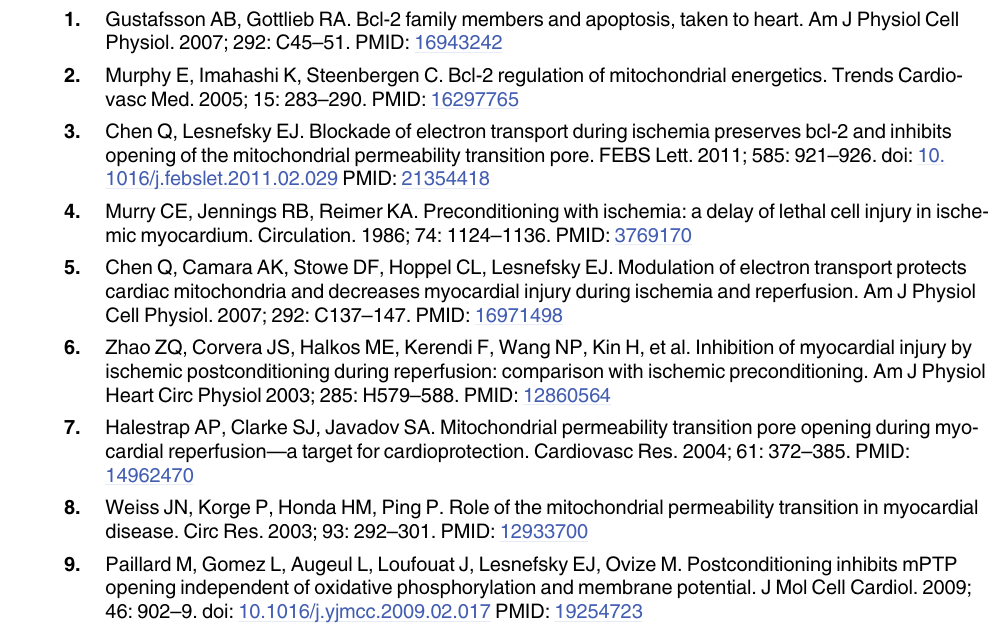
S3 Fig. Ischemia-reperfusion decreased cytosolic bcl-2 content. Buffer perfused rat hearts were subjected to 25 min global ischemia and 30 min reperfusion. Bcl-2 content in cytosol was determined using western blotting. The bcl-2 content is decreased in hearts following ische- mia-reperfusion compared to time control. Tubulin was used as a protein loading control. S4 Fig. Ischemia-reperfusion decreased bcl-2 content in rat. Rat SSM were isolated at the end of heart perfusion. Bcl-2 content was determined using western blotting. Panels A and B: The bcl-2 content is decreased in rat SSM following reperfusion compared to time control (Mean ± SEM; (cid:1) p < 0.05 vs. non-ischemic control). S1 Table. The alteration of oxidative phosphorylation in buffer perfused rat hearts follow- ing ischemia (ISC) and reperfusion (REP). S2 Table. Ischemia (ISC) alone leads to decreased rate of oxidative phosphorylation in rab- bit heart